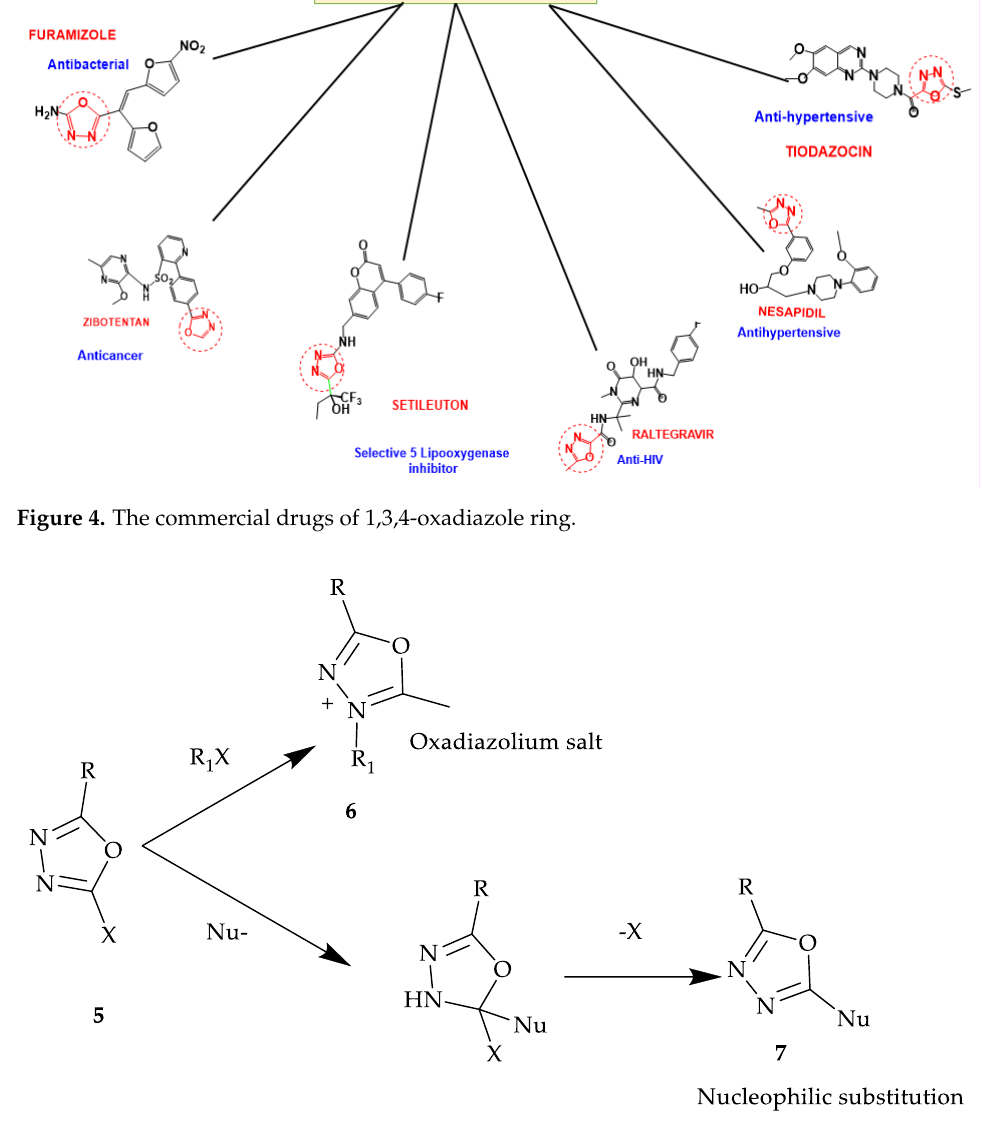
Figure 4. The commercial drugs of 1,3,4-oxadiazole ring.